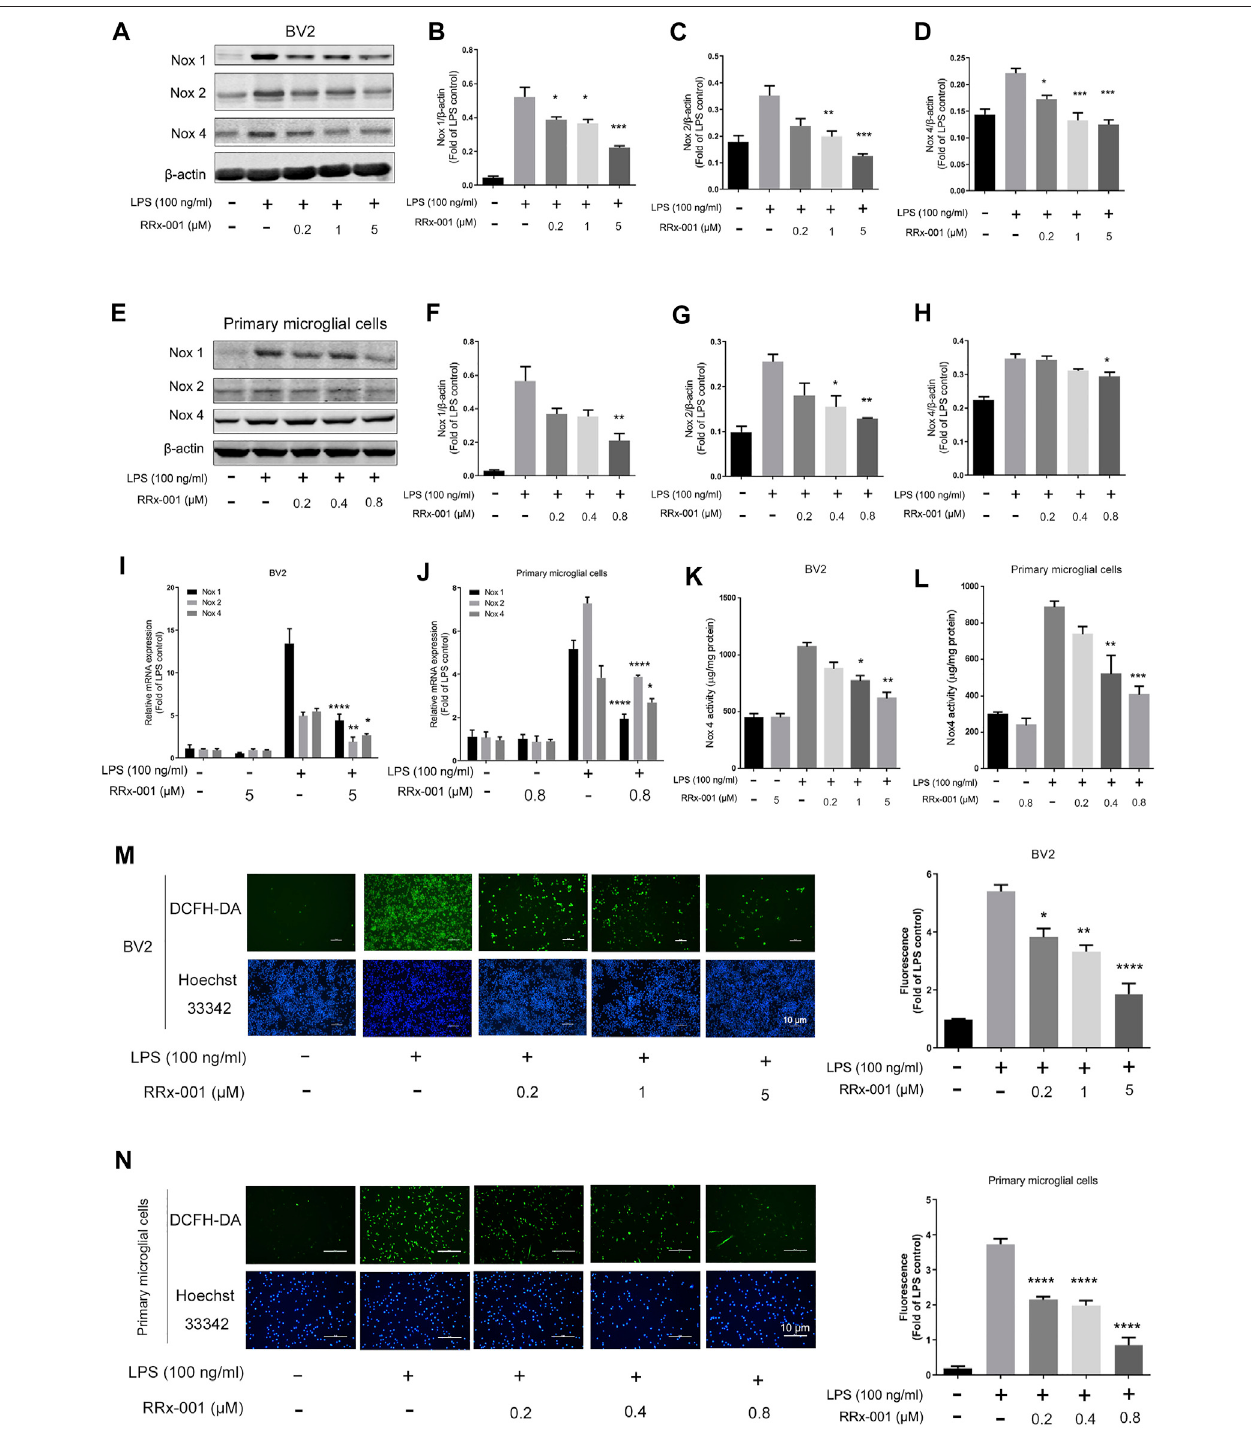
FIGURE 7 | RRx-001 ameliorated LPS-induced oxidative stress by inhibiting the Nox family. (A – H) The cells were treated in the same way as in Figure 1(A – H) . After the cells were harvested, the protein levels of Nox1, Nox2, Nox4 and β -actin were detected using a western blotting assay. The relative intensity of Nox4 relative to β -actin was quanti fi ed in the bar fi gures. (I,J) The cells were treated in the same way as in Figures 2A,B . After the total RNA was extracted, the mRNA levels of Nox1, Nox2andNox4weredeterminedwithqRT-PCR. (K,L) Thecellsweretreatedinthesamewayasin Figures1I,J .Afterthecellswereharvested,theactivityofNox4 wasmeasured byELISAkits. (M,N) BV2cellswerepretreated withRRx-001at proportionate dosesof0.2,1and5 μ M,and primarymicrogliawithRRx-001 atdosesof 0.2, 0.4 and 0.8 µM for 12 h, and then stimulated with LPS (100 ng/ml) for 30 min. The intracellular levels of ROS were measured by using the fl uorescentprobe